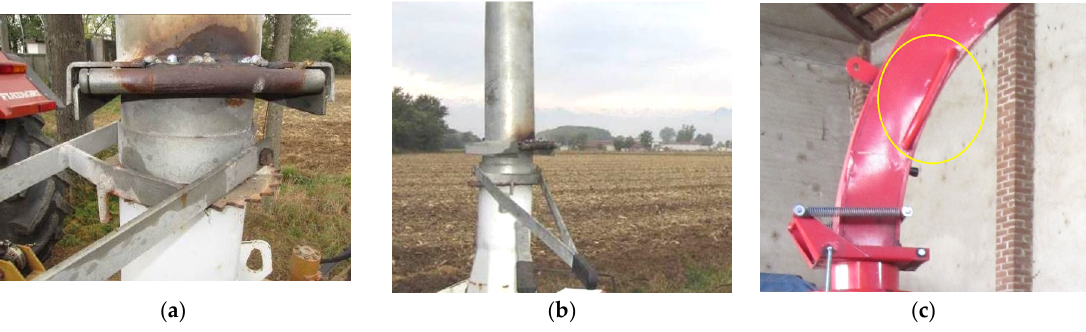
Figure 11. The discharge chute of the examined machine ( a ) and ( b ) was lacking in the two handles